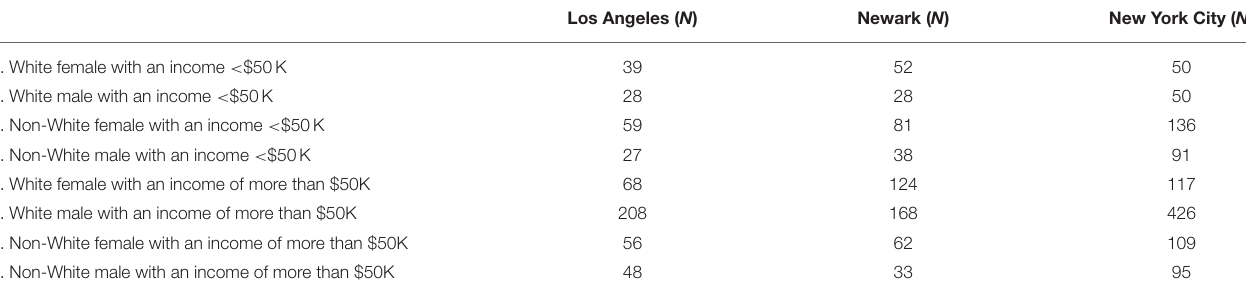
TABLE 3 | Survey participants that garden according to the eight mutually exclusive demographic groups by